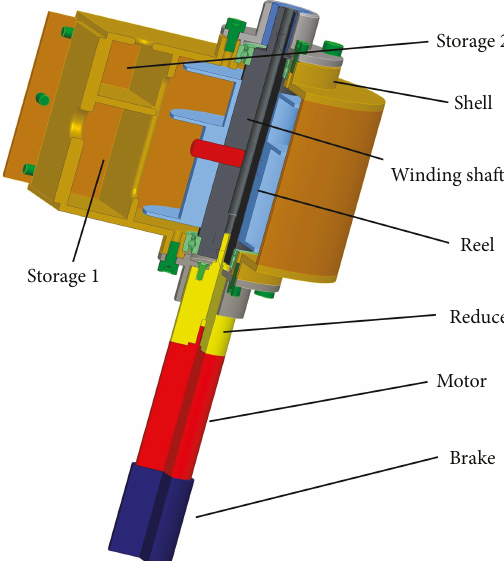
Figure 6: Schematic diagram of the winding unit.